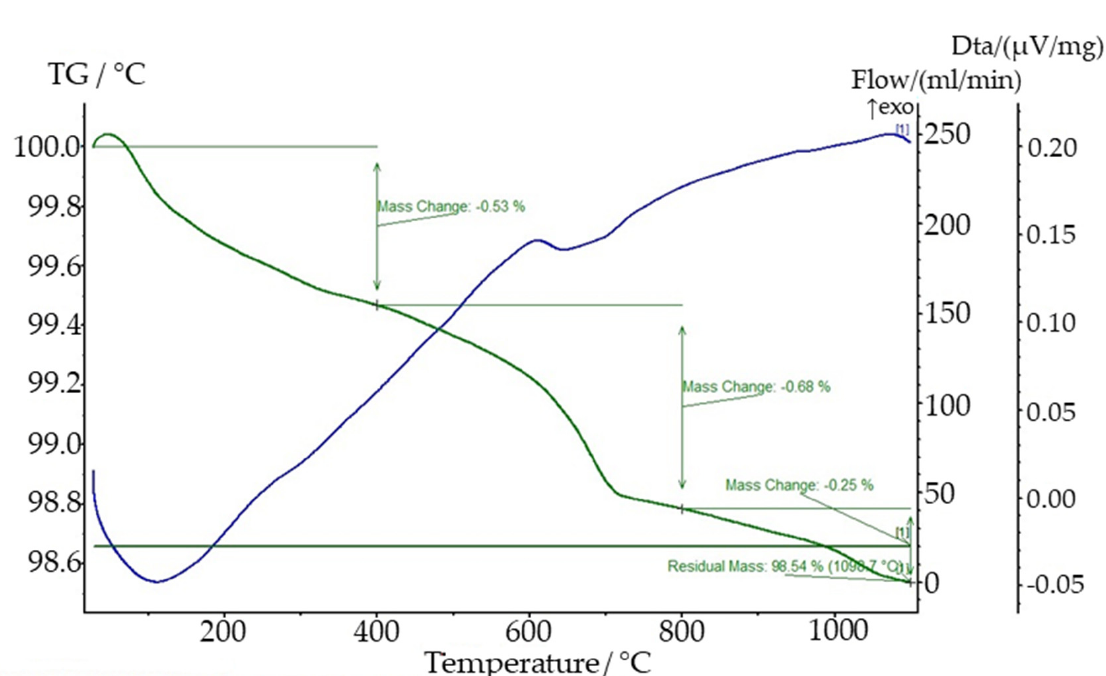
Figure 6. DTA–TGA curves of the potassium feldspar sample.